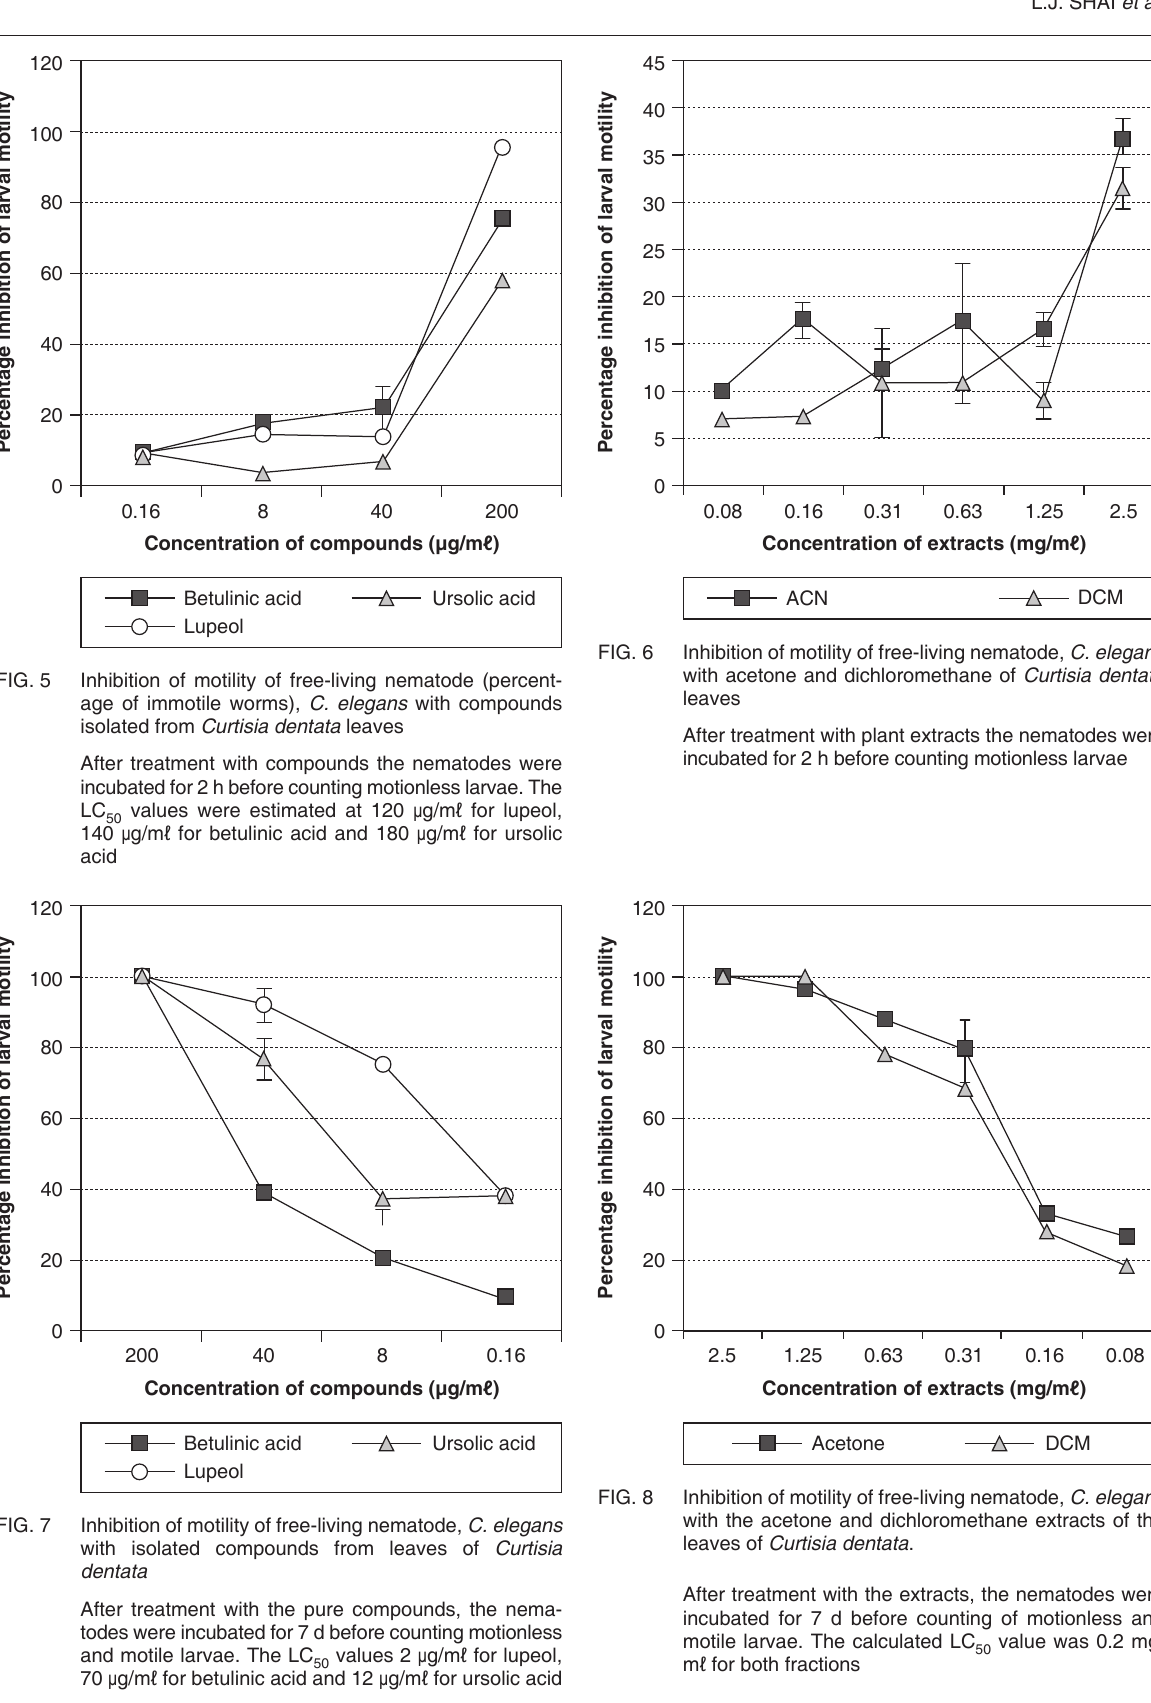
After treatment with the pure compounds, the nema- todes were incubated for 7 d before counting motionless values 2 μ g/m ℓ for lupeol, and motile larvae. The LC 50 70 μ g/m ℓ for betulinic acid and 12 μ g/m ℓ for ursolic acid